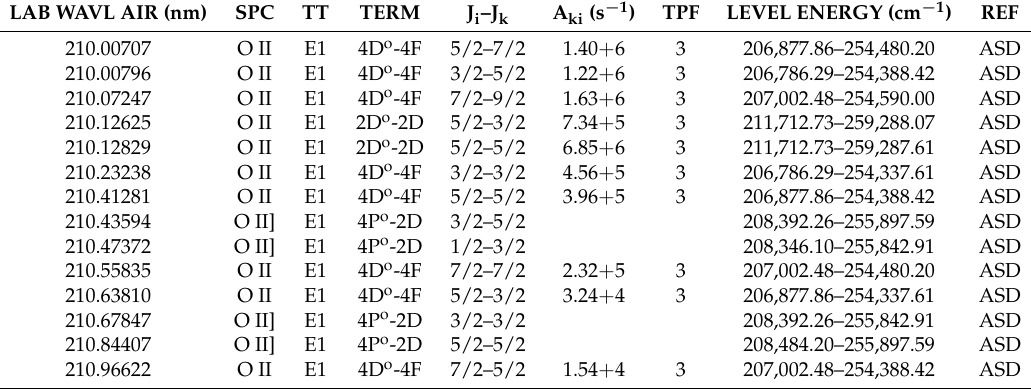
Table 1. Sample output from a simple query. The first column gives the laboratory wavelength in air (in nm), the second column the species, the third column the transition type, the fourth column the term of the lower and upper level, the fifth column the total angular momentum of the lower and upper level, the sixth column the transition probability (in s − 1 ), the seventh column the transition probability literature source, the eighth column the energy of the lower and upper level (in cm − 1 ), and the ninth column the literature source for the level energies. Entries x . xx + y stand for x . xx × 10 y